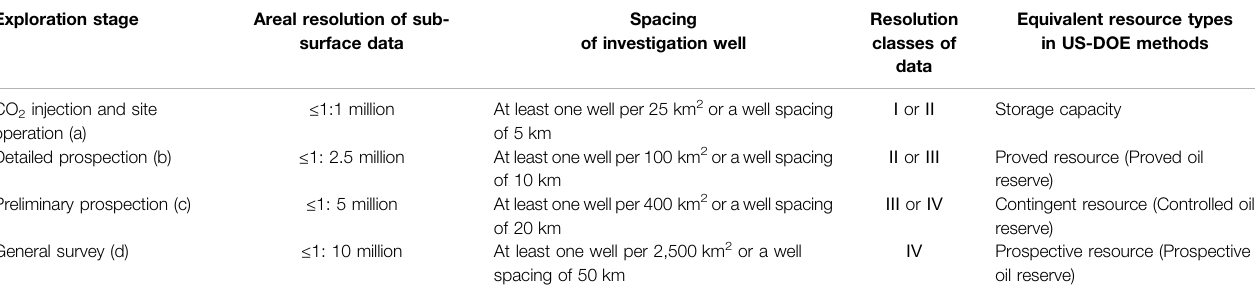
TABLE 3 | Proposed hierarchical classi fi cation of sub-surface geological